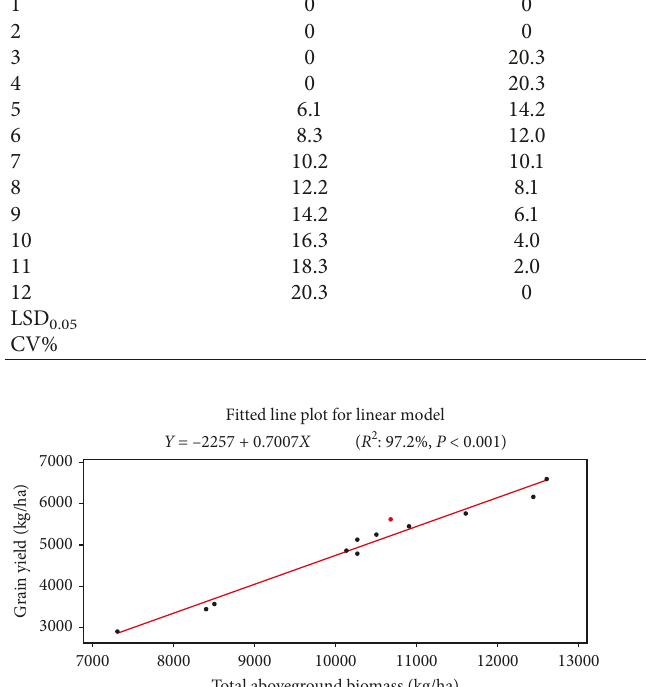
Table 4: Grain and total biomass yield of maize as affected by the combined application of Tithonia biomass and phosphorus fertilizer (TSP) ( Serbo , years 1 and 2). Treatment no.